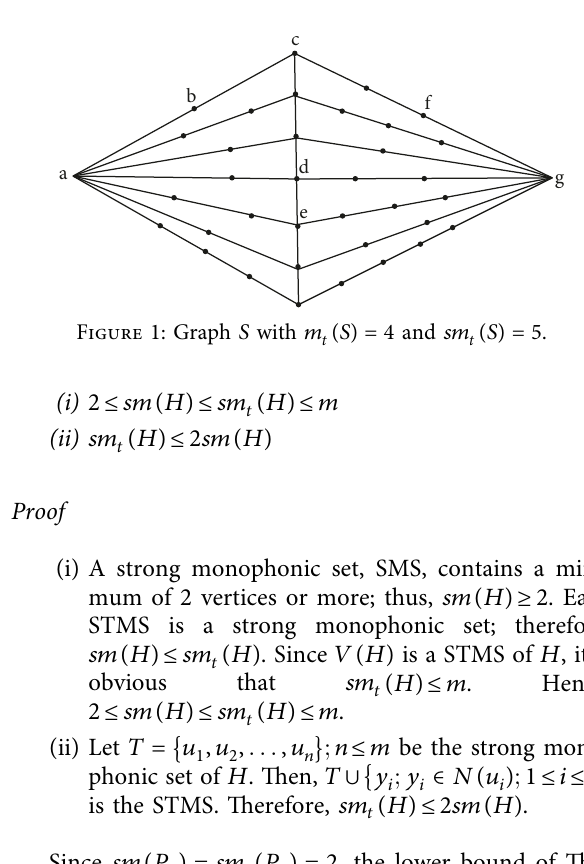
Figure 1: Graph S with m